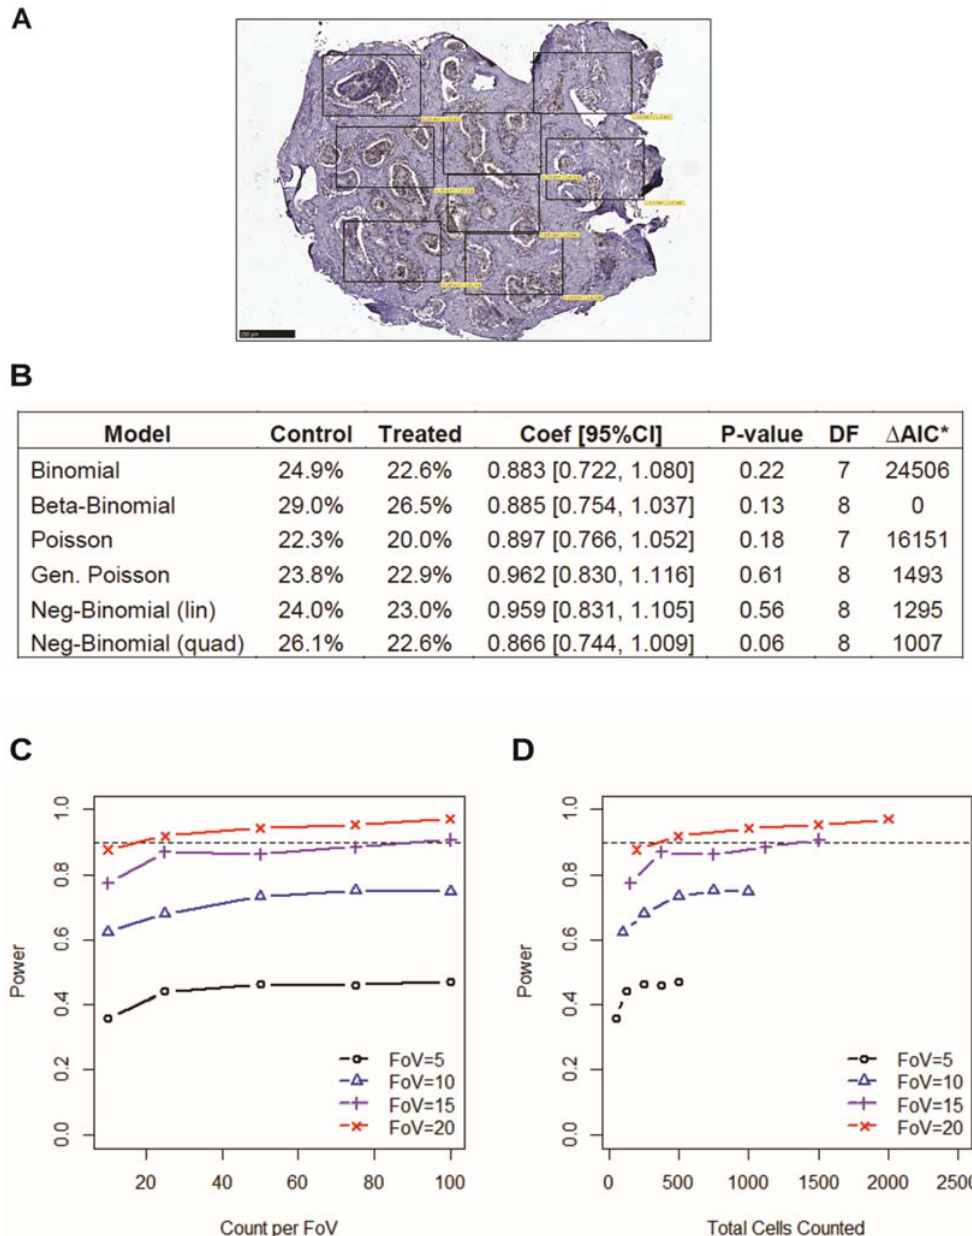
Figure 3. Variation–response modeling of histological cell counts. ( A ) Ki67 cell counts were manually counted across the entire section of PDE tissues using multiple fields-of-view (FoV) for modeling cellular heterogeneity. Each box represents one FoV. ( B ) Mixed effects modeling results for Ki67 immunostaining of PDE tissues cultured in the presence of control or treated with 10 µ M enzalutamide ( n = 122). Coef = coefficient; CI = confidence interval; DF = degrees of freedom; AIC–Aikake information criterion. * ∆ AIC is the difference from that of the beta-binomial model, which had the smallest AIC. ( C , D ) Ki67 data were simulated assuming a beta-binomial mixed effects model, using set parameters estimated for Ki67. Power is plotted against the number of ( C ) FoV, and ( D ) cell counts per FoV.